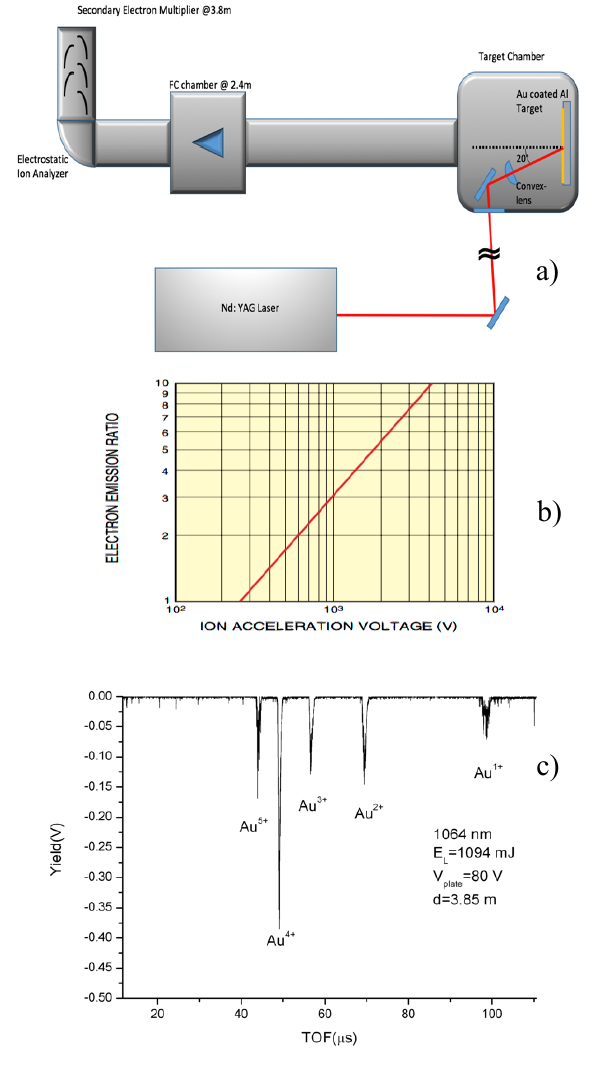
Fig. 1. Experimental setup of BNL laboratory for Plasma diagnostics. b) The Electron emission ratio for Hamamatsu SEM R2362. c) Example of IEA spectra obtained at